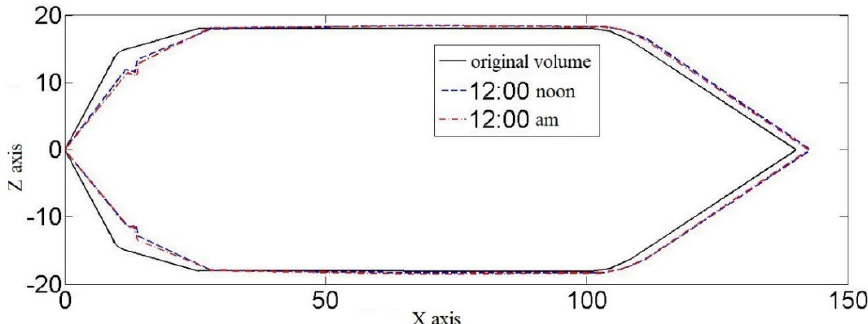
Figure 13. The comparison of airship shapes (X-Z view) (units: m).